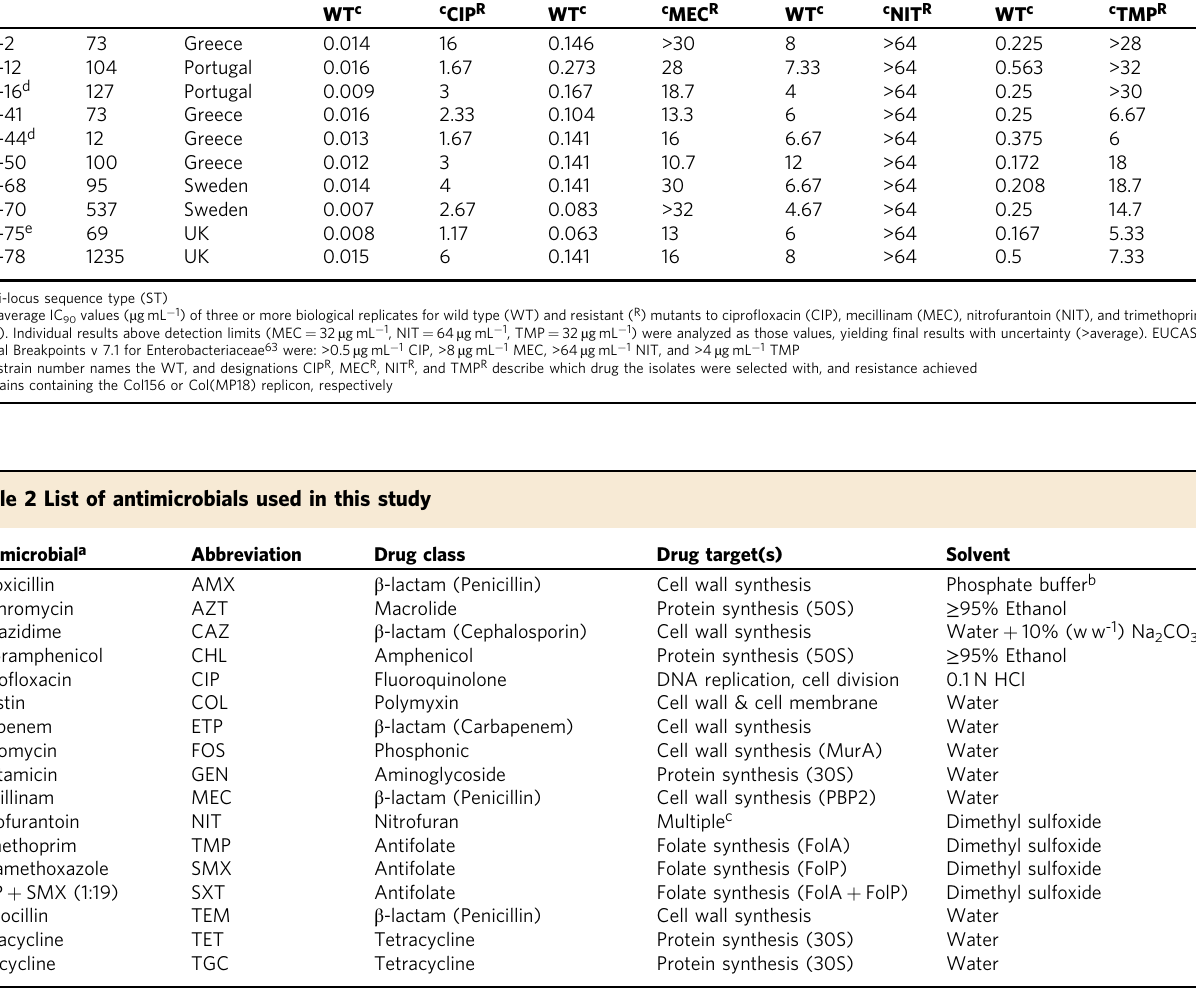
Table 1 Description of Escherichia coli strains used in the study and average IC 90 changes following antimicrobial selection Strain ST a